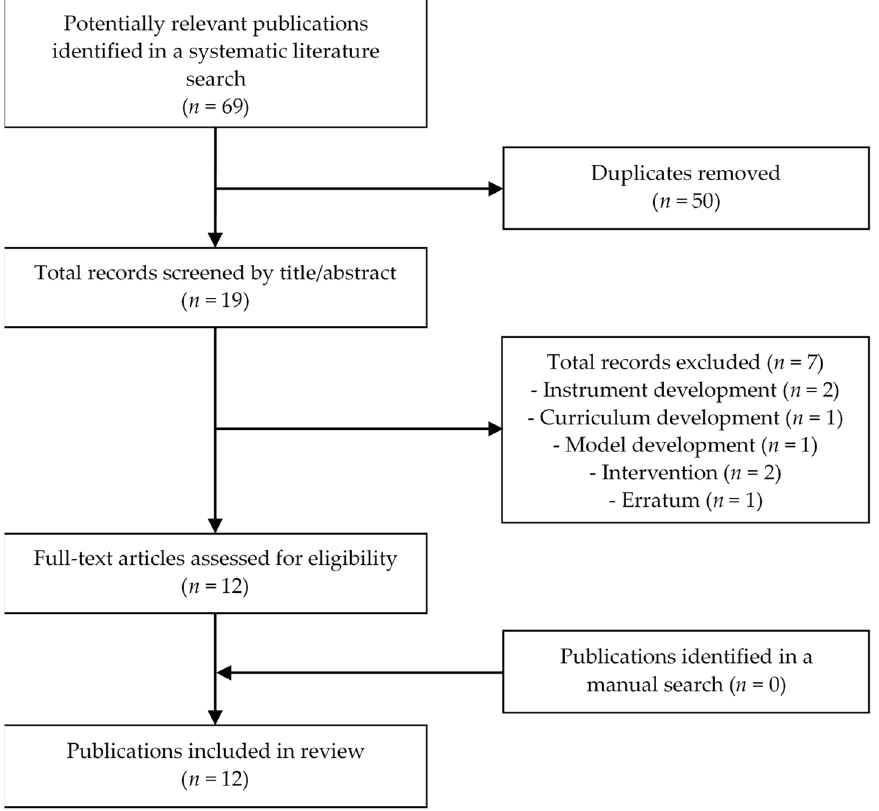
Figure 1. Flow chart of the literature search process.